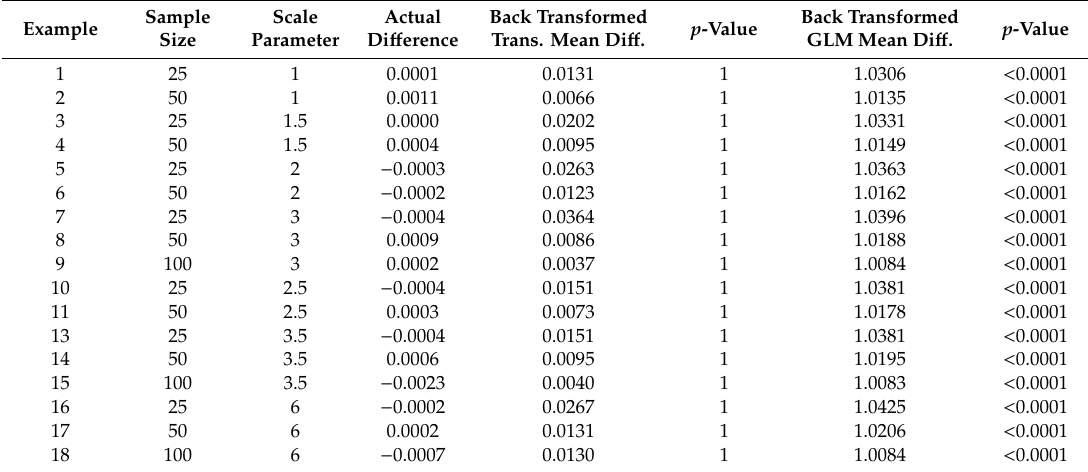
Table 5. Mean di ff erences estimates’ values for original, log-transformed and GLM-fitted exponential distributed